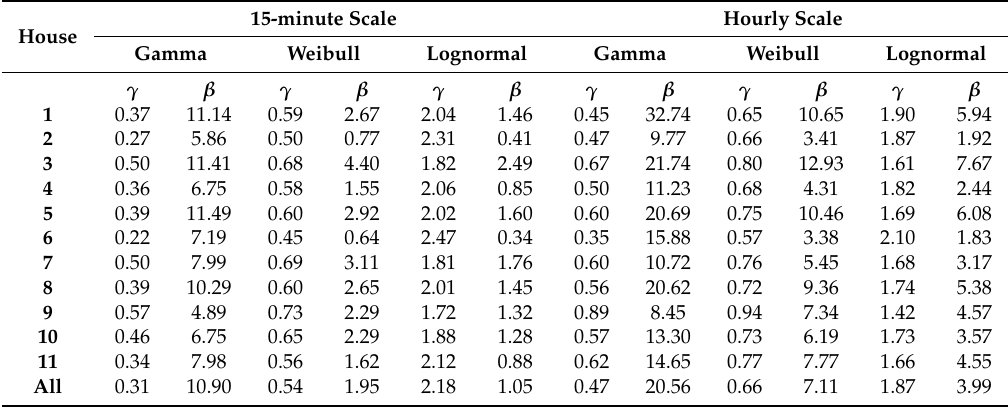
Table A7. Shape and scale parameters of the three understudy distributions fitted on the entire records of each